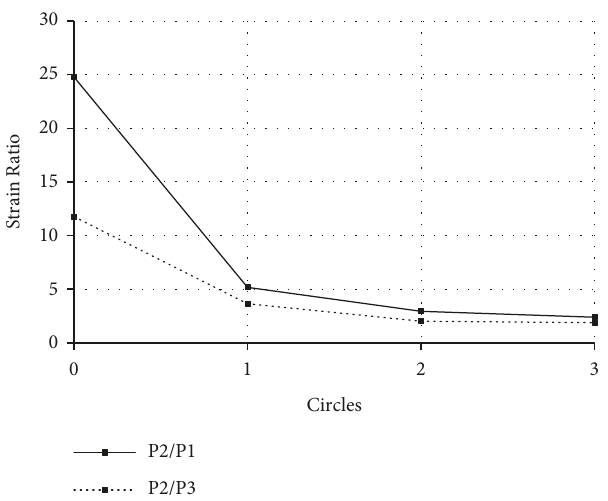
Figure 13: Strain ration relationship between piers under Tianjin ground motion. Table 2: Maximum acceleration for different frequency spectra (g).